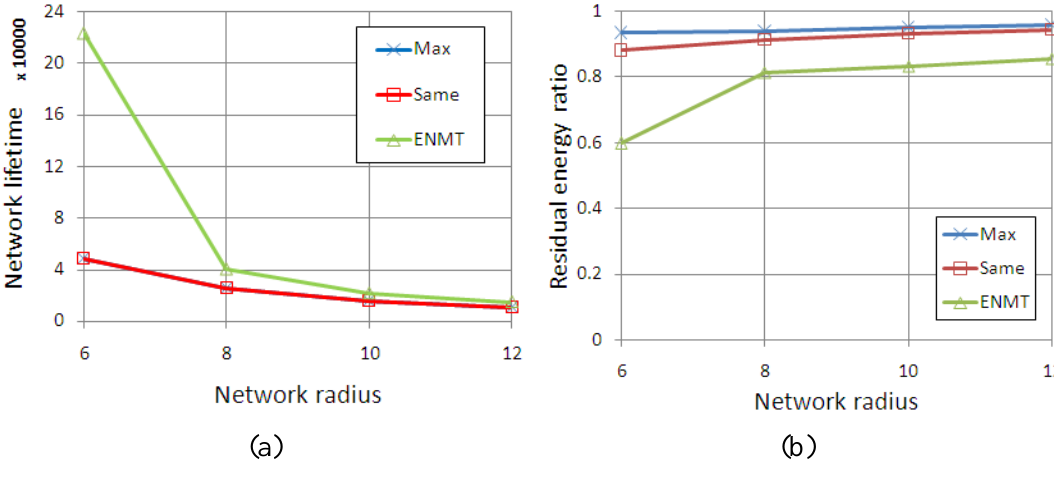
Figure 6. Simulation results (2 and 4). (a) Network Lifetime. (b) Residual energy